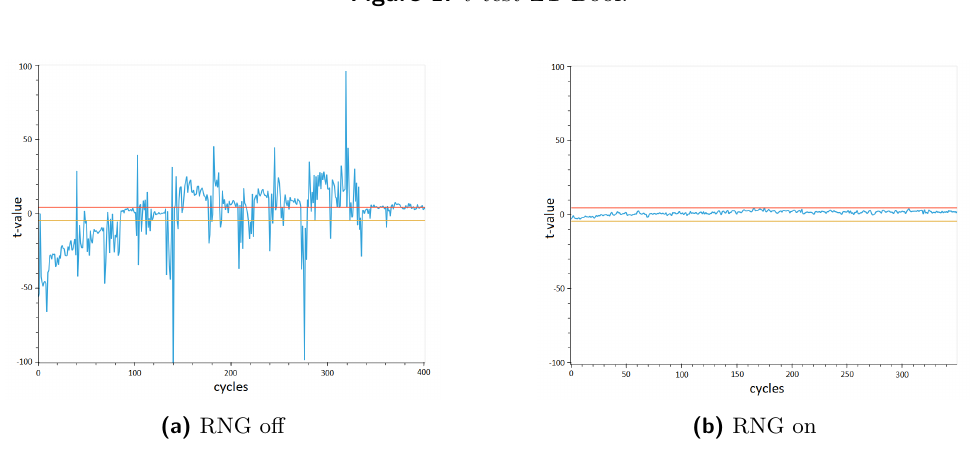
Figure 1: t -test ZT-Bool.